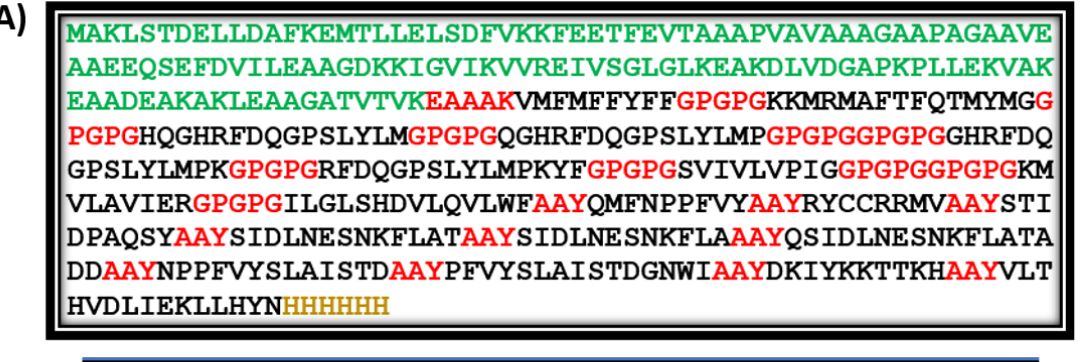
Figure 4. ( A ) Final vaccine construct of all antigenic but nonallergenic epitopes selected from the target proteins; ( B ) ToxinPred predicting the toxic residues in red and potential toxic residues in blue.